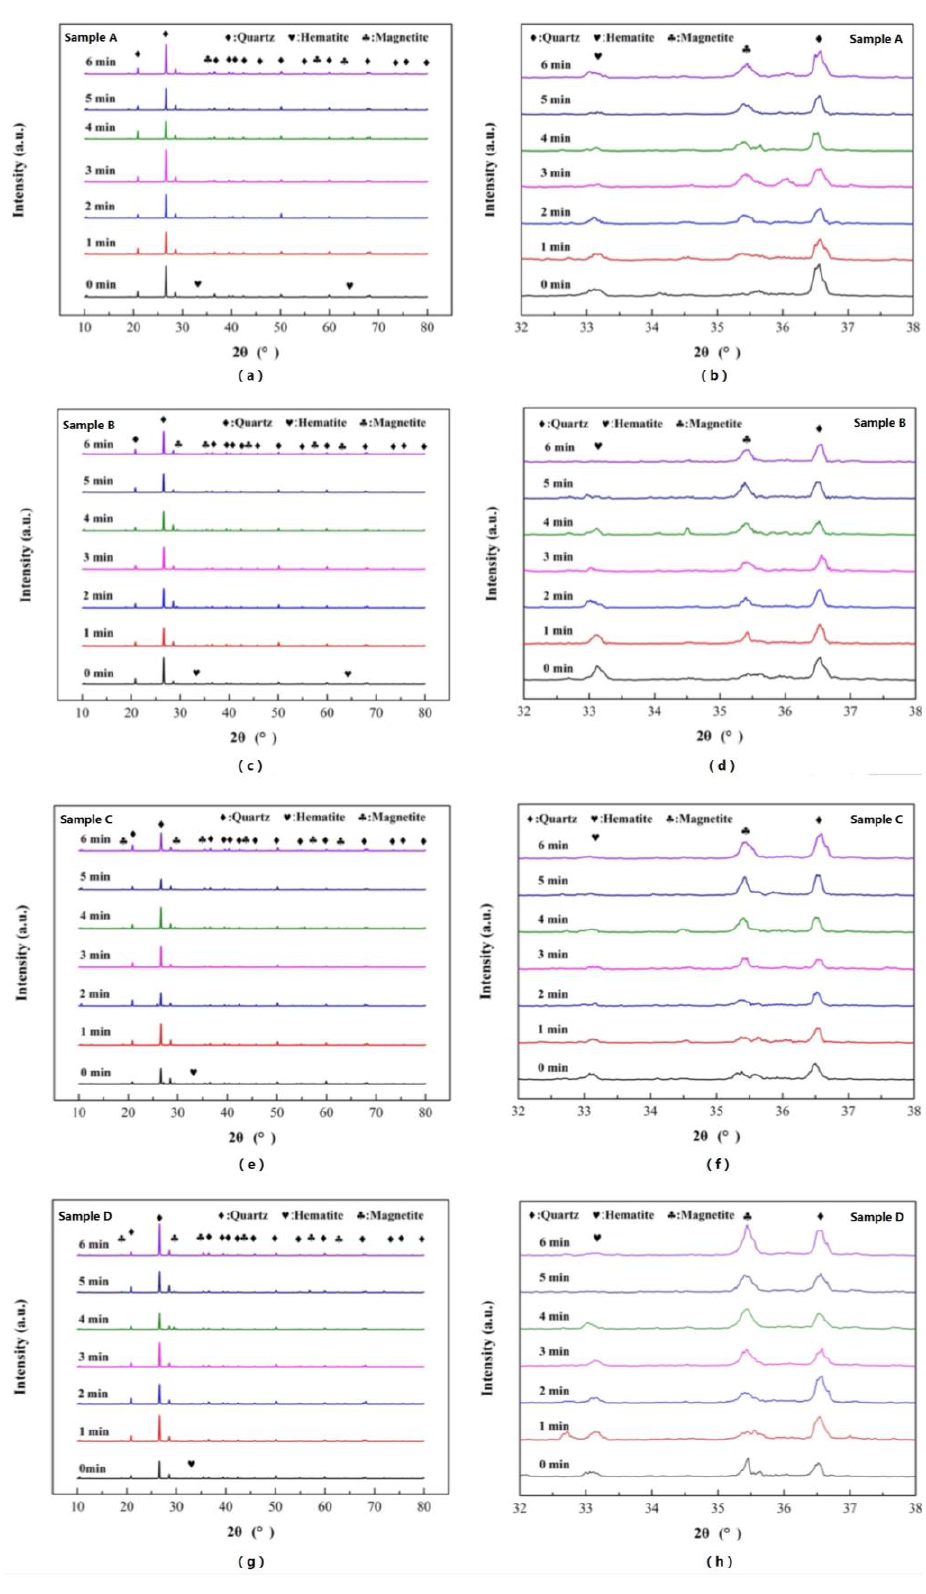
Figure 13. XRD patterns of sample A to D at different roasting times. ( a , b ): Sample A, ( c , d ): Sample B, ( e , f ): Sample C, ( g , h ): Sample D.